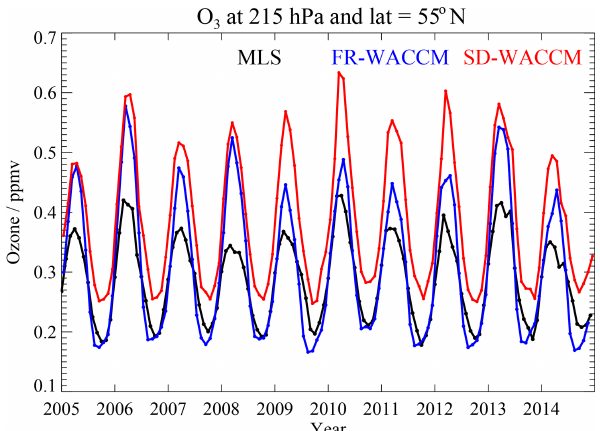
Figure 2. Monthly mean ozone time series at 215hPa and the 55 ◦ N latitude bin (for averages over 50–60 ◦ N) from MLS, FR-WACCM, and SD-WACCM (see legend for color coding).